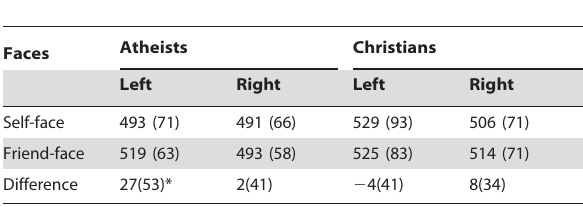
Table 2. Mean RTs(ms) (SD) and difference in RTs in Experiment 2.